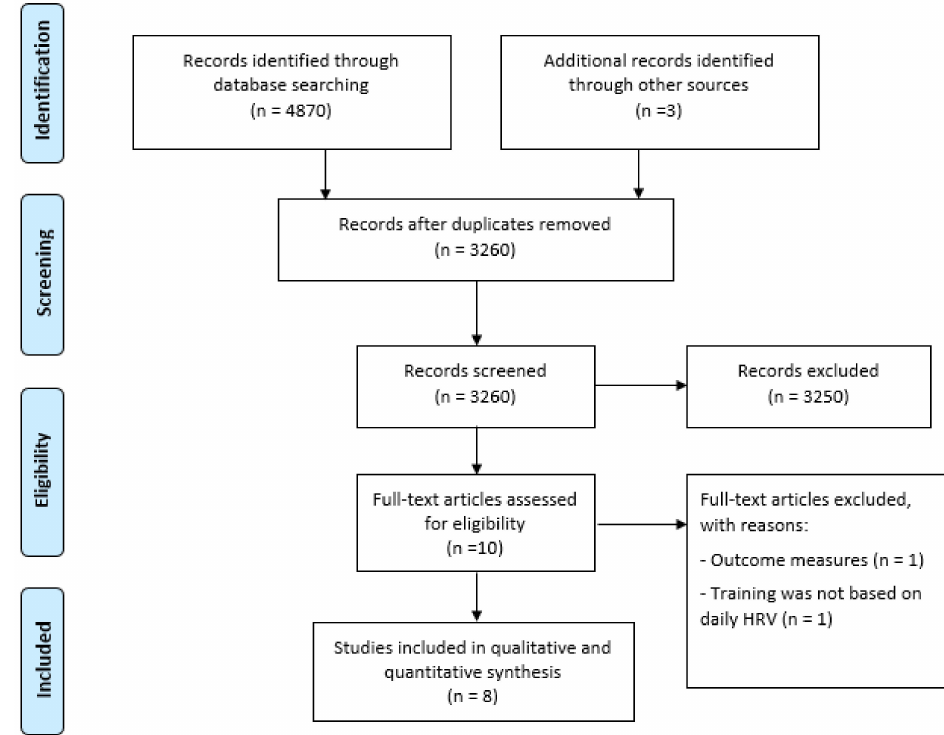
Figure 1. Flow chart of the systematic review